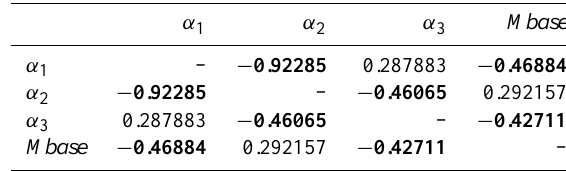
Table 3. Pearson correlation coefficient values for tuning parame- ters of successful model runs ( n = 29). Correlation coefficients with p values < 0.05 are highlighted in